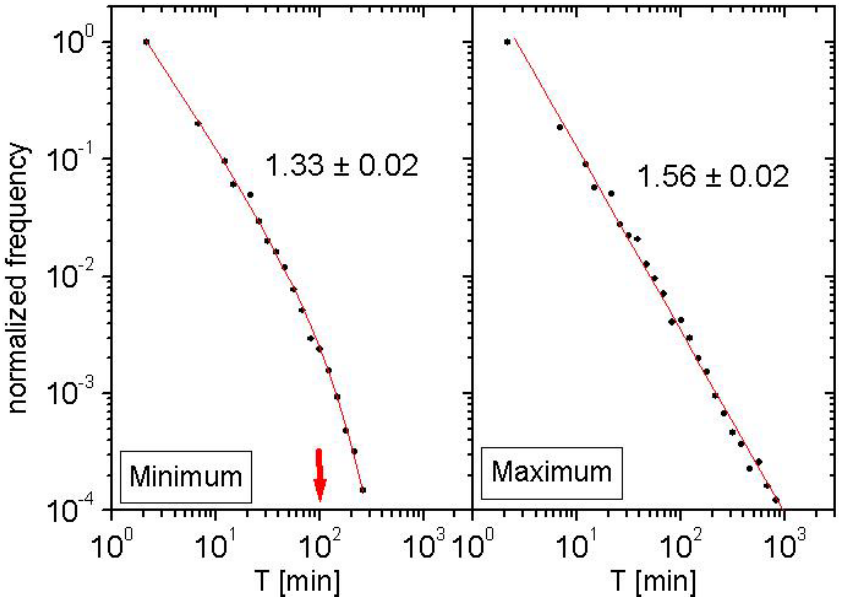
Fig. 2. Waiting time distributions of B s at solar minimum and maximum on the left- and right-hand side panels, respectively. The points are derived from an average of the histogram over logarithmically, equally spaced intervals and are normalized to the maximum value. The solid lines refer to the fits computed by Eq. (1). The red arrow, in the left panel, indicates the position of the cutoff. The slope of the power law is indicated in the picture.